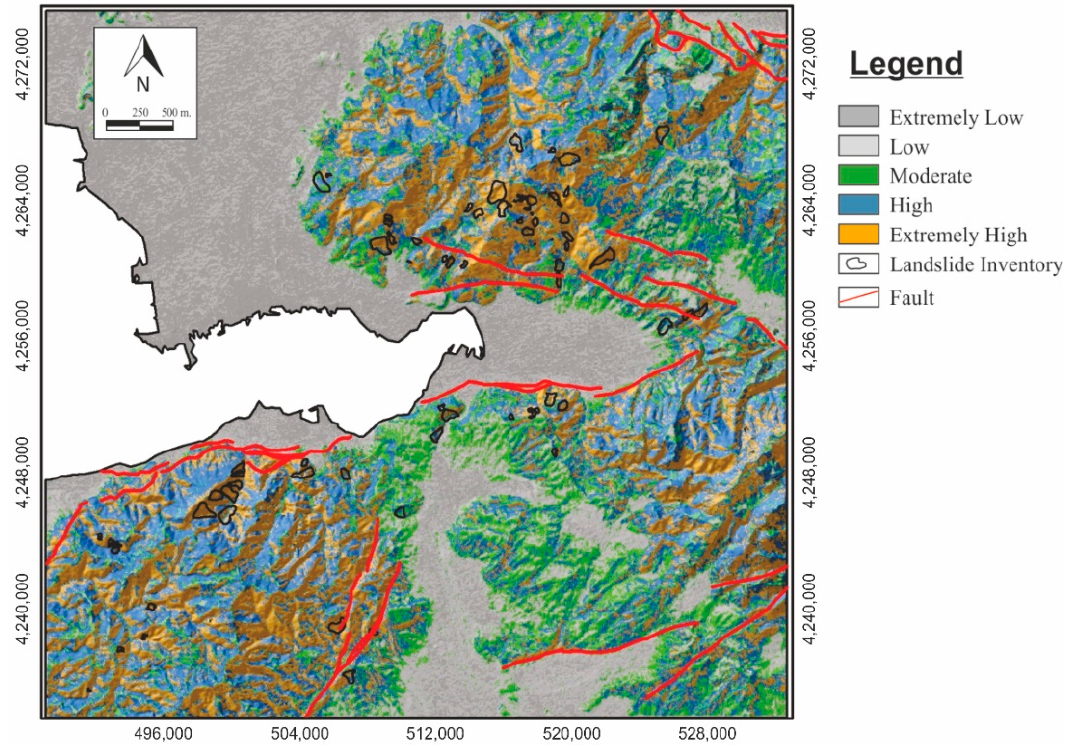
Figure 11. Landslide susceptibility map prepared with the combined method.